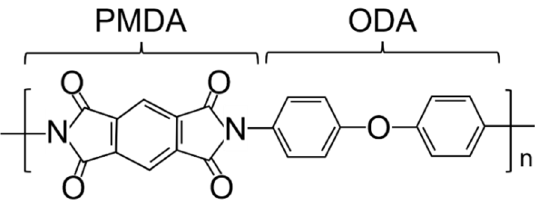
Figure 1. Molecular formula of ODA-PMDA polyimide.